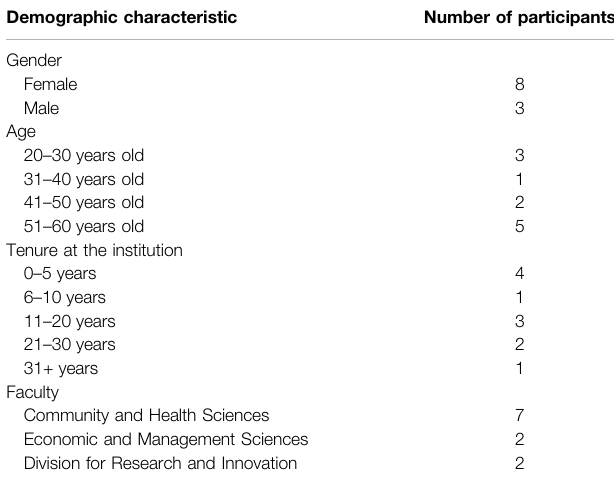
TABLE 1 | Collaborative autoethnography research participants ’ demographics ( n (cid:1) 11). Demographic